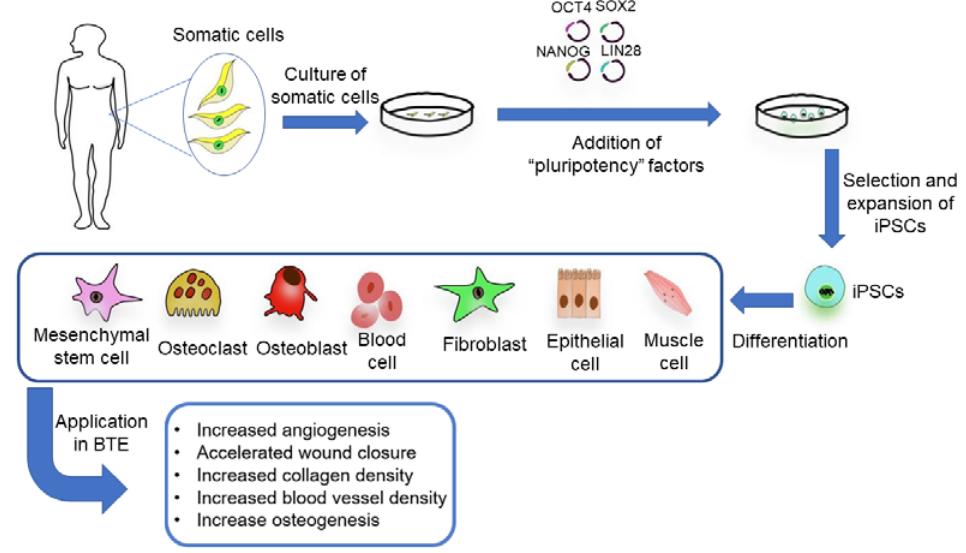
Figure 3. The generation and application of iPSCs in bone tissue engineering.